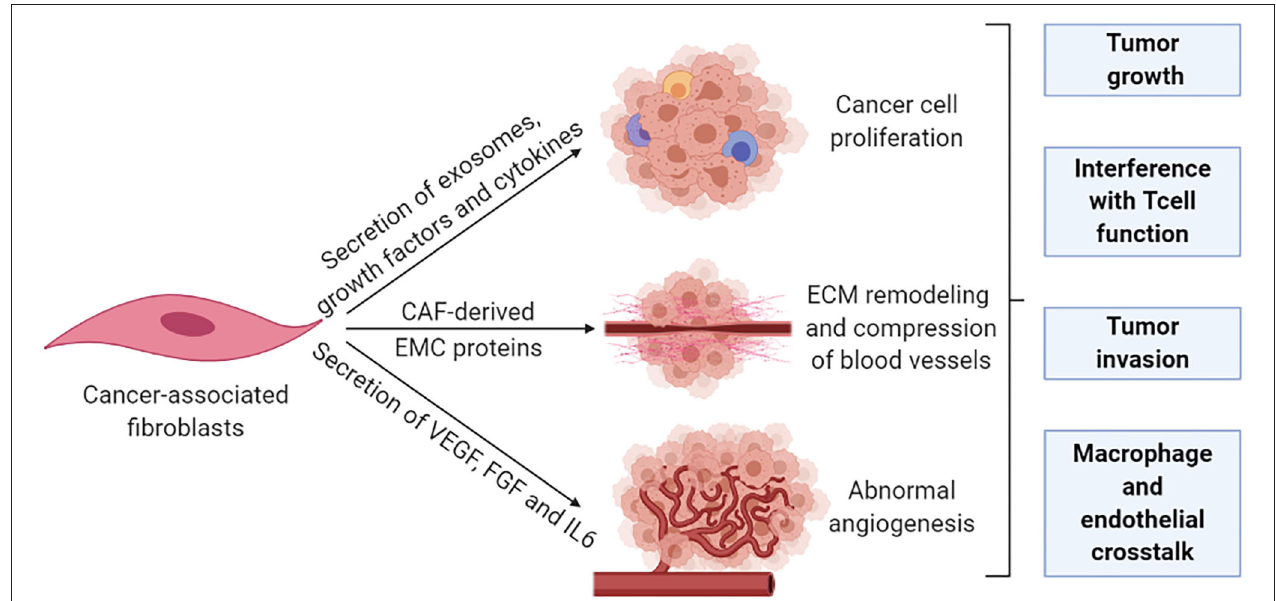
FIGURE 4 | Cancer-associated fibroblasts remodel the tumor stroma. The pro-tumorigenic functions of CAFs are generally associated with their highly secretory activity. Secretory functions and matrix remodeling contribute to tumor invasion and angiogenesis. In addition, secreted soluble factors also contribute to immune reprogramming and tumor growth. Metabolic remodeling by CAFs supports an immunosuppressive microenvironment and promotes tumor